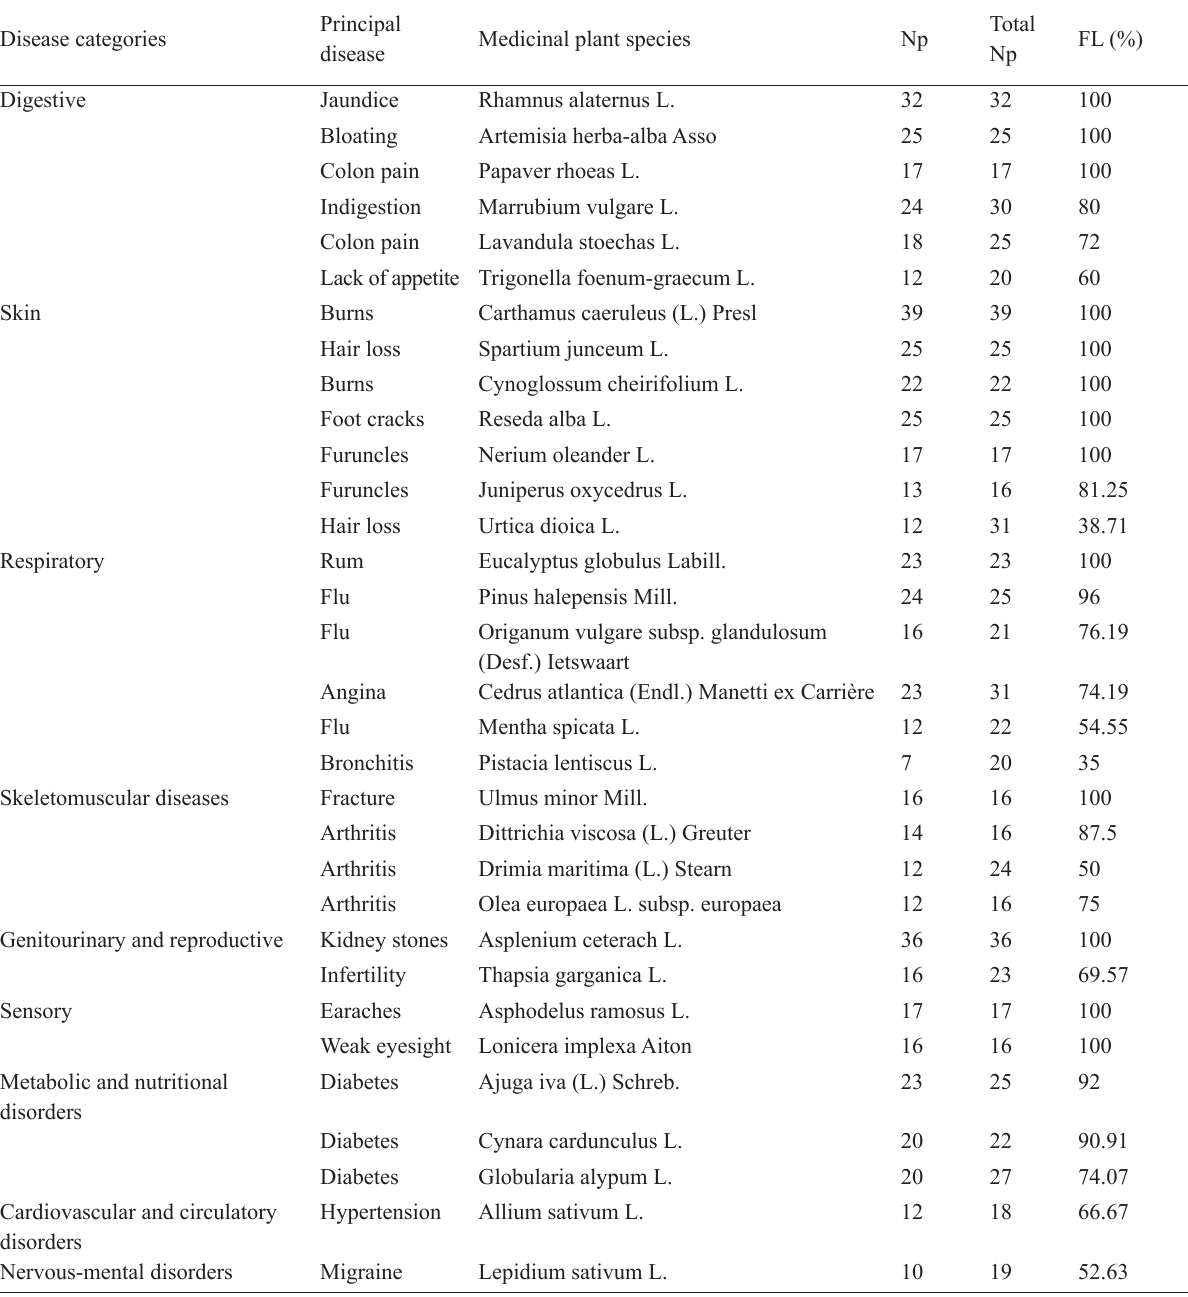
Table 4. Fidelity level (FL) values of the most cited plant species (number of informants (Np) ≥ 16) Disease